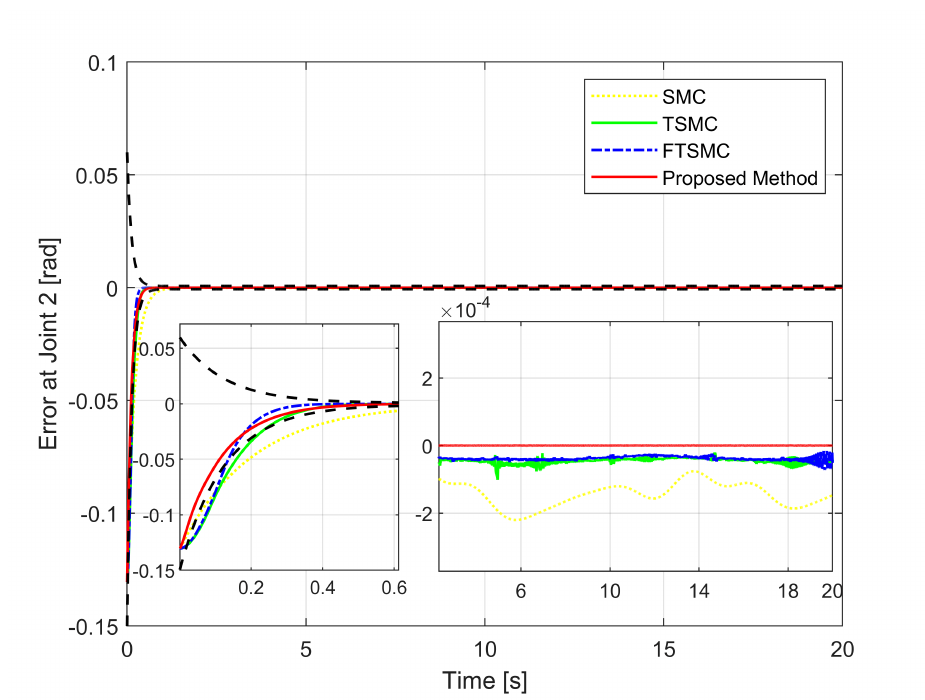
Figure 7. Tracking error of the second joint versus the desired trajectory.